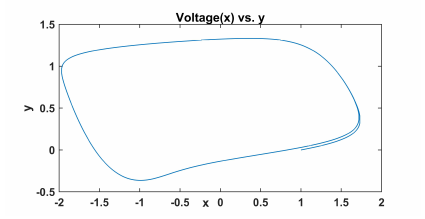
Figure 10. Recovery variable (right) with a constant external current value, I(t) = 1.1 µ A / cm 2 , a = 0.8 , b = 0.7 & c = 3